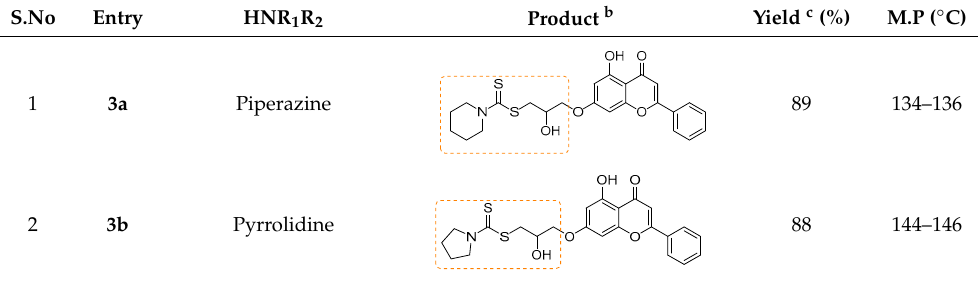
Table 1. Synthesis of novel 2-hydroxy-3-chrysino dithiocarbamate derivatives 3a – k catalyzed by LiBr a . S.No